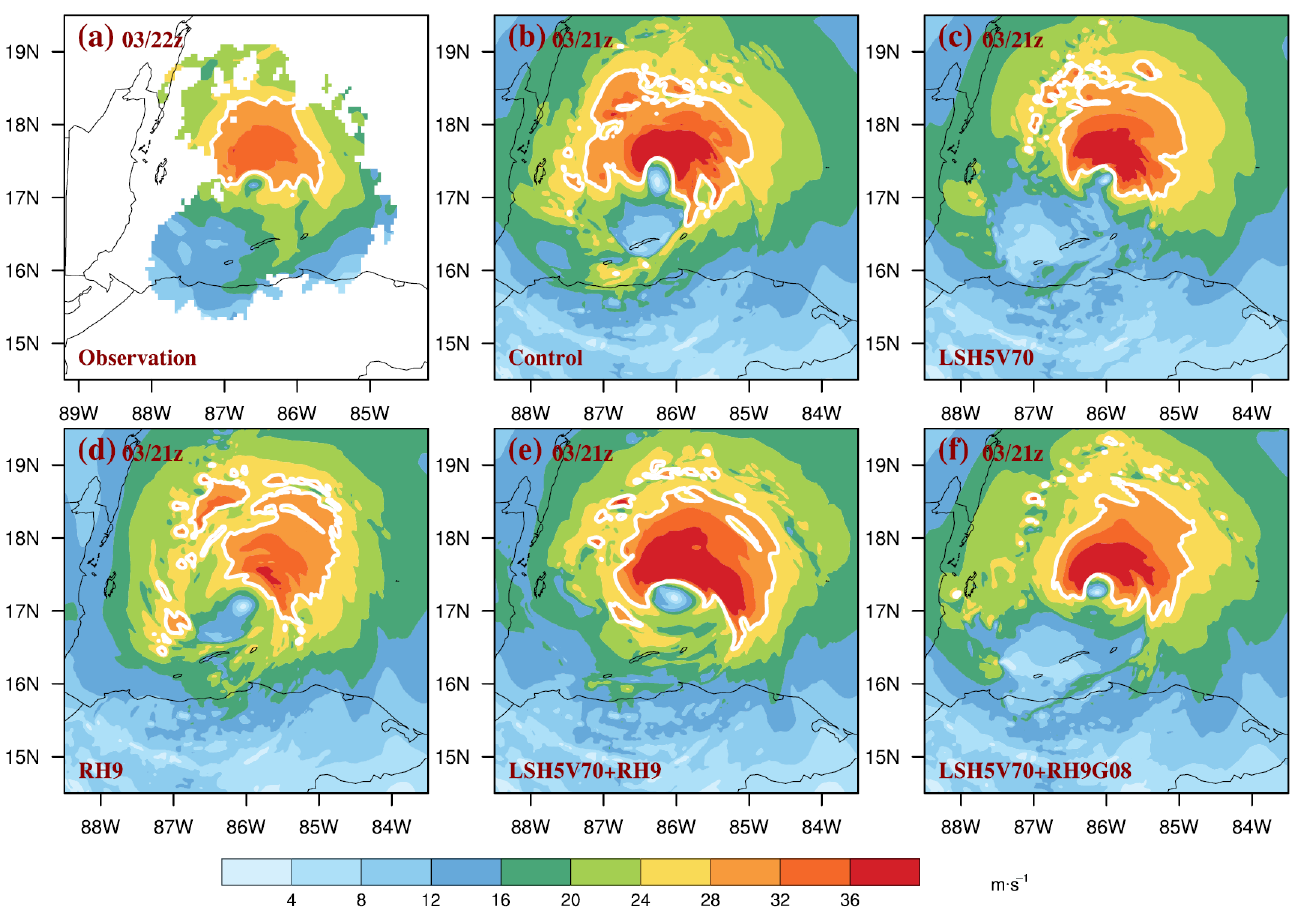
Figure 17. The 1500 m wind from ( a ) NOAA Doppler radar, ( b ) Control, ( c ) LSH5V70, ( d ) RH9, ( e ) LSH5V70 + RH9, and ( f ) LSH5V70 + RH9G08 for Hurricane Earl during landfall at 21 UTC 03 August 2016. The white contour line represents winds over 28 m·s −1 for observations and simulations.